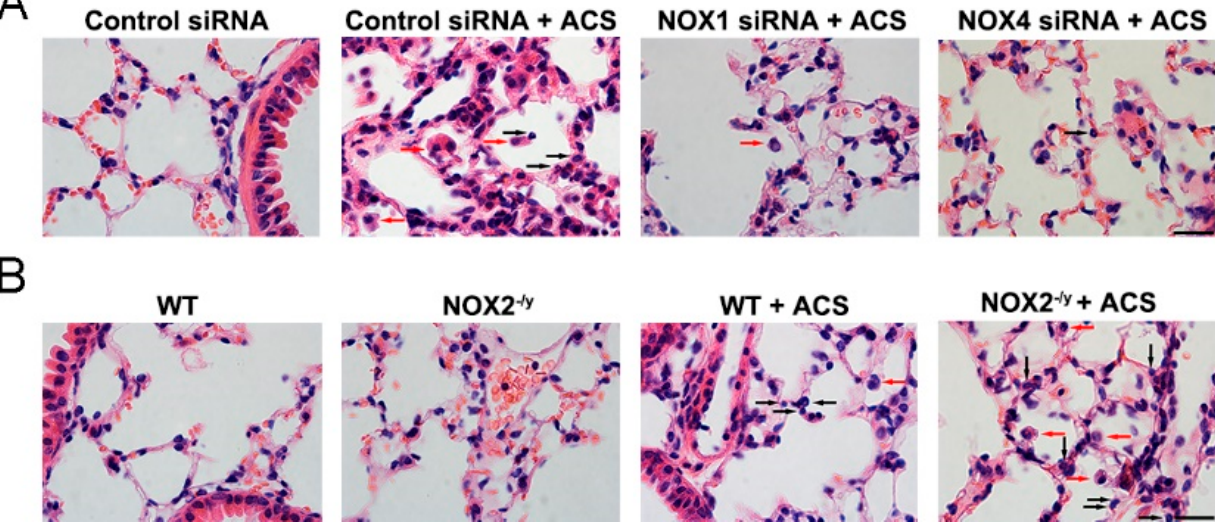
Figure 5. Knockdown of NOX1 or NOX4 in mice attenuated ACS induced lung inflammation . Mice were exposed to CS or filtered air for 1 h and harvested at 6 h. Lung tissue sections were stained with H&E, and the data indicate an increase in the numbers of macrophages (red arrowheads) and neutrophils (black arrowheads) infiltrating alveolar spaces in response to ACS in control siRNA- transfected or WT control mice. ( A ) Representative H&E images indicating that ACS exposed mice silenced of NOX1 or NOX4 expression had reduced inflammatory cell infiltration compared to con- trol siRNA-transfected mice. ( B ) Representative H&E images indicating that ACSexposed NOX2 − /y